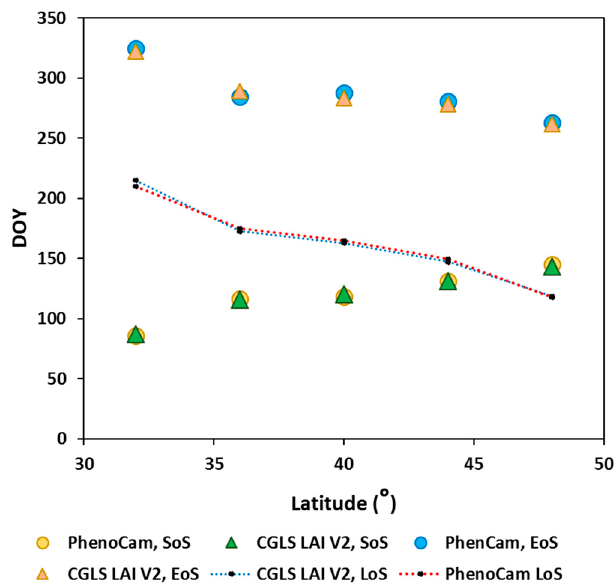
Figure 6. Latitudinal gradients of average phenological metrics for the start (SoS), end (EoS) and length of season (LoS) extracted from CGLS LAI V2 and PhenoCam GCC time series over the PhenoCam deciduous sites in North America (Figure 1). Data was aggregated in five groups of latitude, taking into account the number of sites: 30–34ºN, 34–38ºN, 38–42ºN, 42–46ºN and 46–53°N.